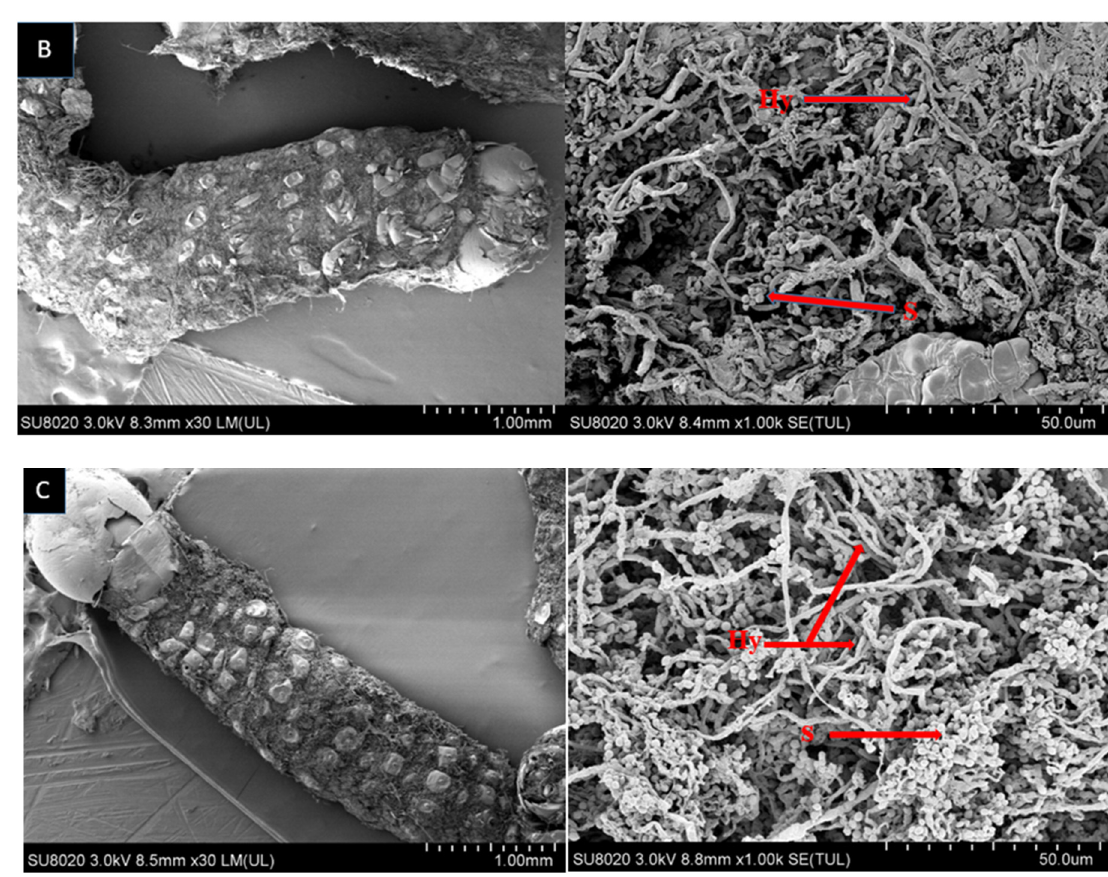
Figure 5. Scanning electron micrograph of infected larval body fully covered with myceli and a closer view showing dense structure of fungal spores and hyphae growing on the body surface: B. bassiana OFDH1-5 ( A ); T. asperellum GDFS1009 ( B ) and B. bassiana OFDH1-5 + T. asperellum GDFS1009 ( C ). Arrow indicates spores (S) and hyphae (Hy).